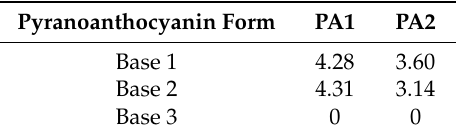
Relative free energies (kcal · mol − 1 ) of the quinonoid bases for pigments